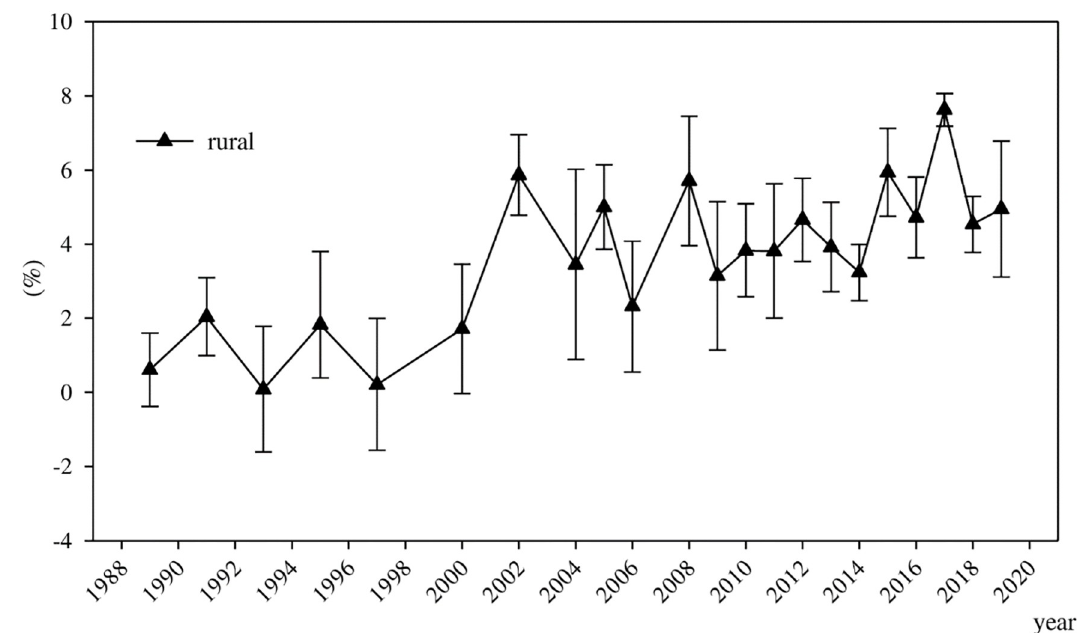
Fig 2. Evolution of returns to education in rural China. Data Source : CHNS, CHIP, CGSS, CFPS, CHFS, and CSS.